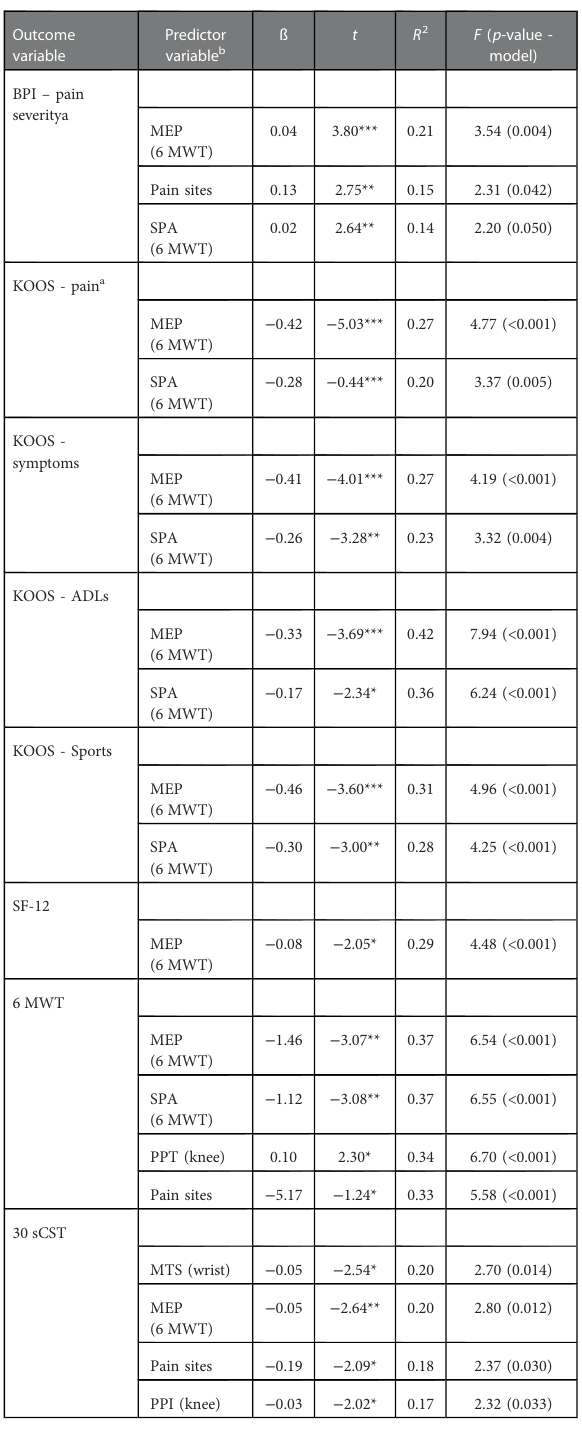
TABLE 5 Adjusted models of cross-sectional associations between measures of sensitization and clinical outcomes at baseline Outcome Predictor variable variable